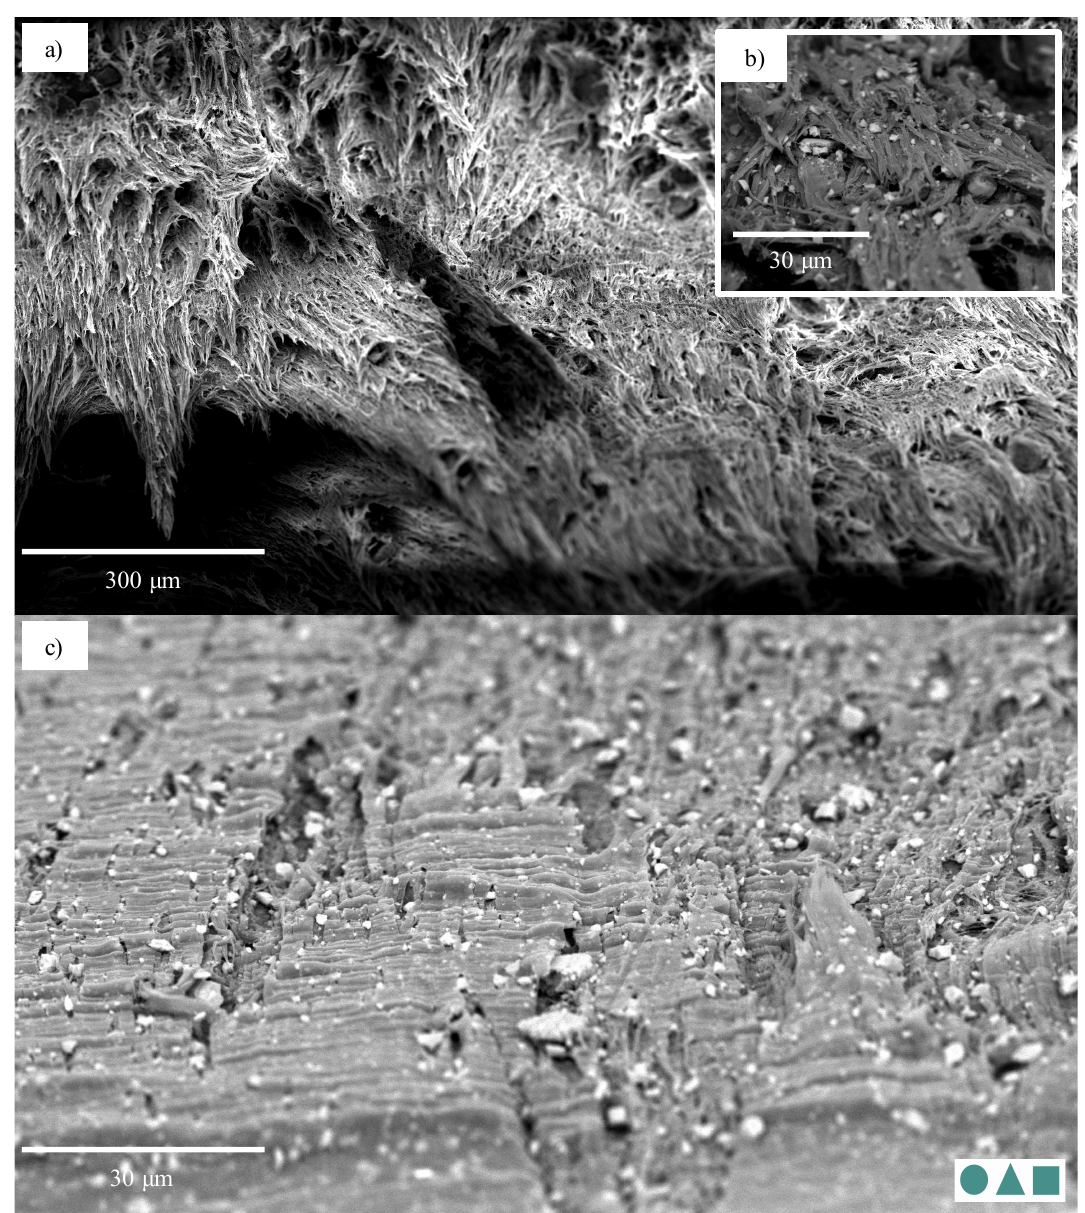
Figure 23. SEM micrographs of the failure regions of a 1.8-CB/30-CC/0.25-SP REF specimen: ( a ) general morphology showing extensive fibrillation; ( b ) detail of fibrillation and particle distribution; ( c ) specimen surface exhibiting wedge-